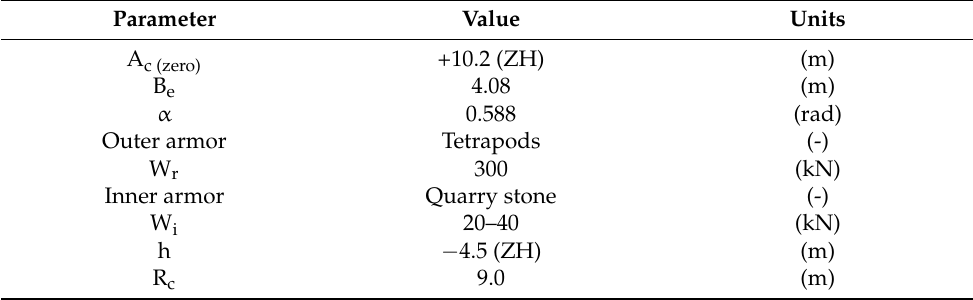
Table 3. Geometric and material parameters of the main outer armor.